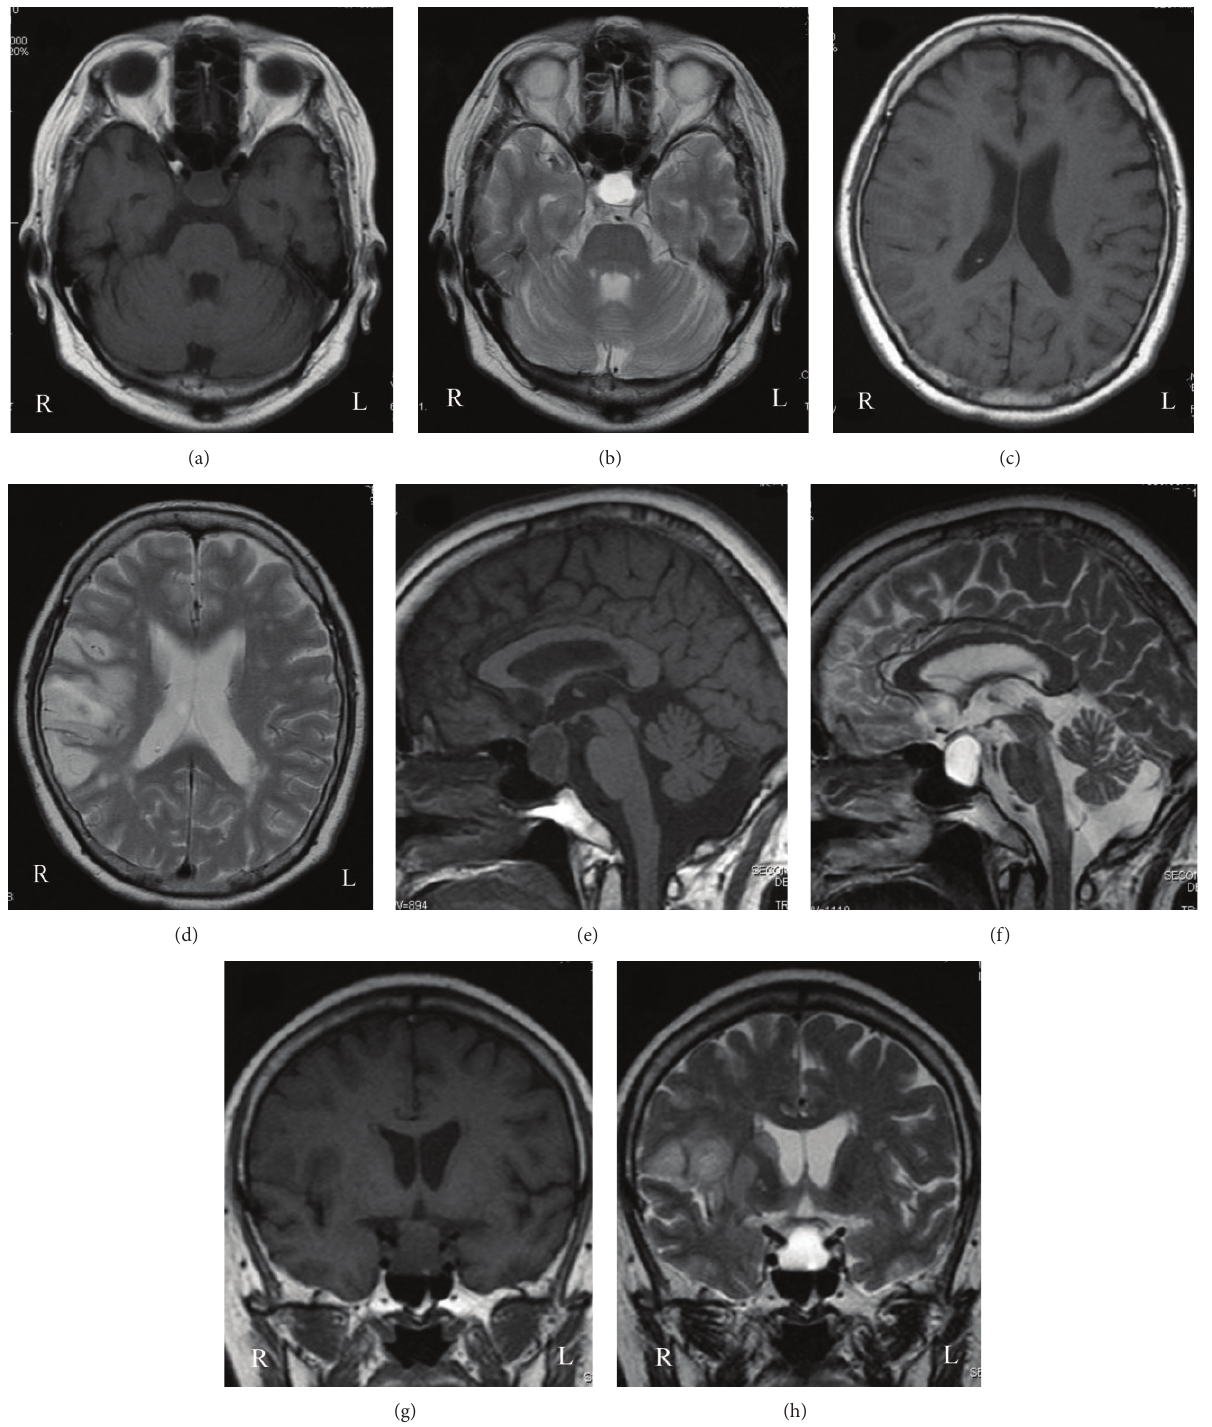
Figure 2: Axial, sagittal, and coronal views of the MRI showed isointensity on T1WI (a, e, and g) and high intensity on T2WI (b, f, and h) in the suprasellar region. Axial and coronal views of the MRI presented isolow intensity on T1WI (c, g) and high intensity on T2WI (d, h) in the territory of the right middle cerebral